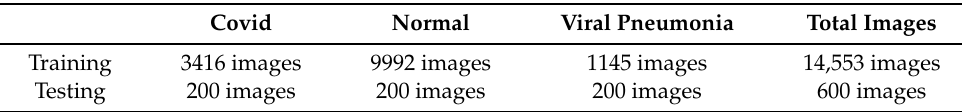
Table 4. The statistics of the chest X-ray